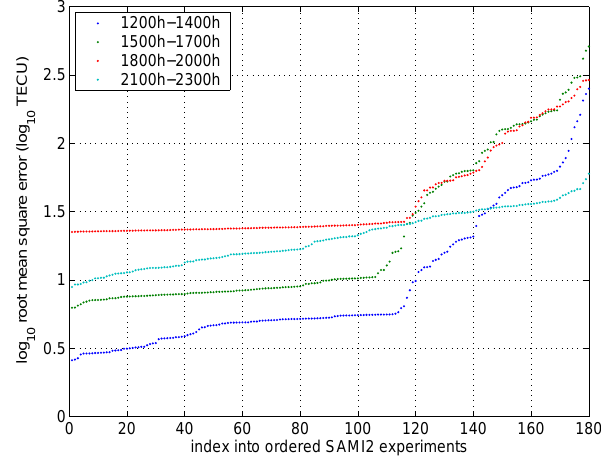
Fig. 6. Ordered sequences of log root mean square (RMS) error in VTEC between ensemble mean from MIDAS and different SAMI2 outputs, for four time windows during 20 November